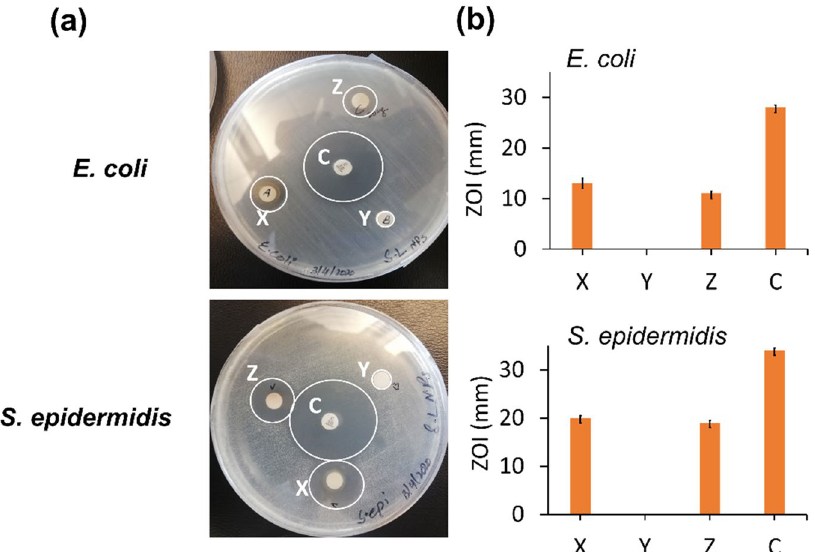
Figure 5. Antibacterial activity of silver nitrate solution, plant extract, AgNPs suspension, and chloramphenicol on E. coli and S. epidermidis . ( a ) Antibacterial efficacy analysis was performed by using Kirby Bauer (disc diffusion) method. Three samples were used i.e. ( X ) 20 μl of SN, ( Y ) 20 μl of SPE and ( Z ) 20 μg of SL-SpNPs whereas chloramphenicol, C was used as a positive control in all experiments. Zones of inhibition (ZOI) around the discs depicts microbial growth inhibition. ( b ) The ZOI were calculated by using a scale in mm and their mean value is shown by bar plots and standard deviation as error bars. No ZOI is found is found for sample